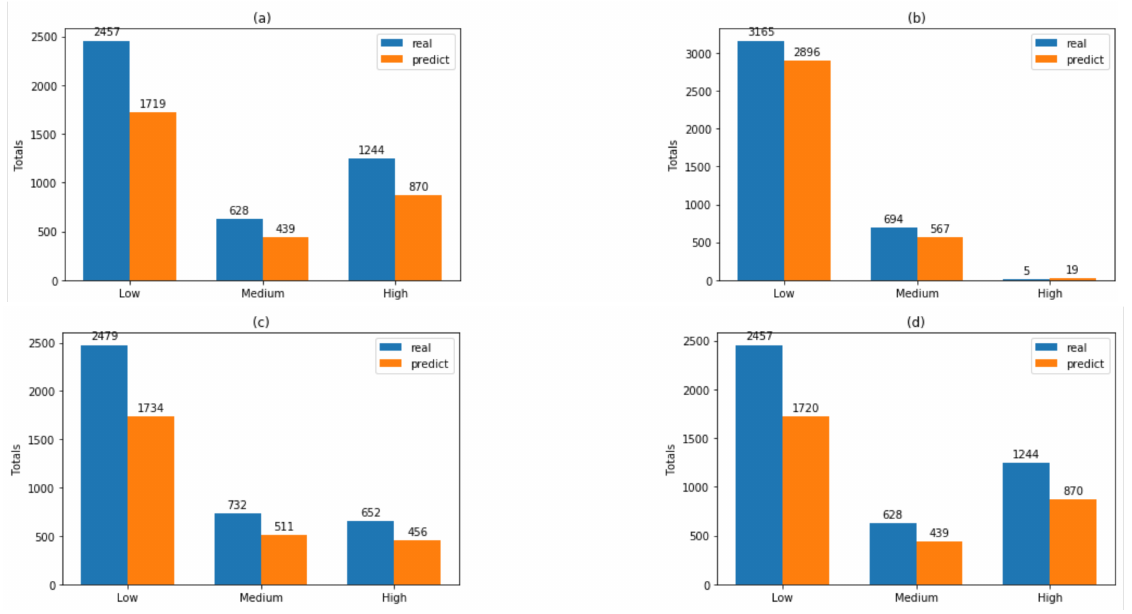
Figure 4. Real vs. predicted values with RF classifier for each dataset, using labels “low”, “medium”, and “high” for the dependent variables. The figure shows the total values of the real versus the classified values: ( a ) with dataset A1; ( b ) with dataset A2; ( c ) with dataset B1; and ( d ) with dataset B2.